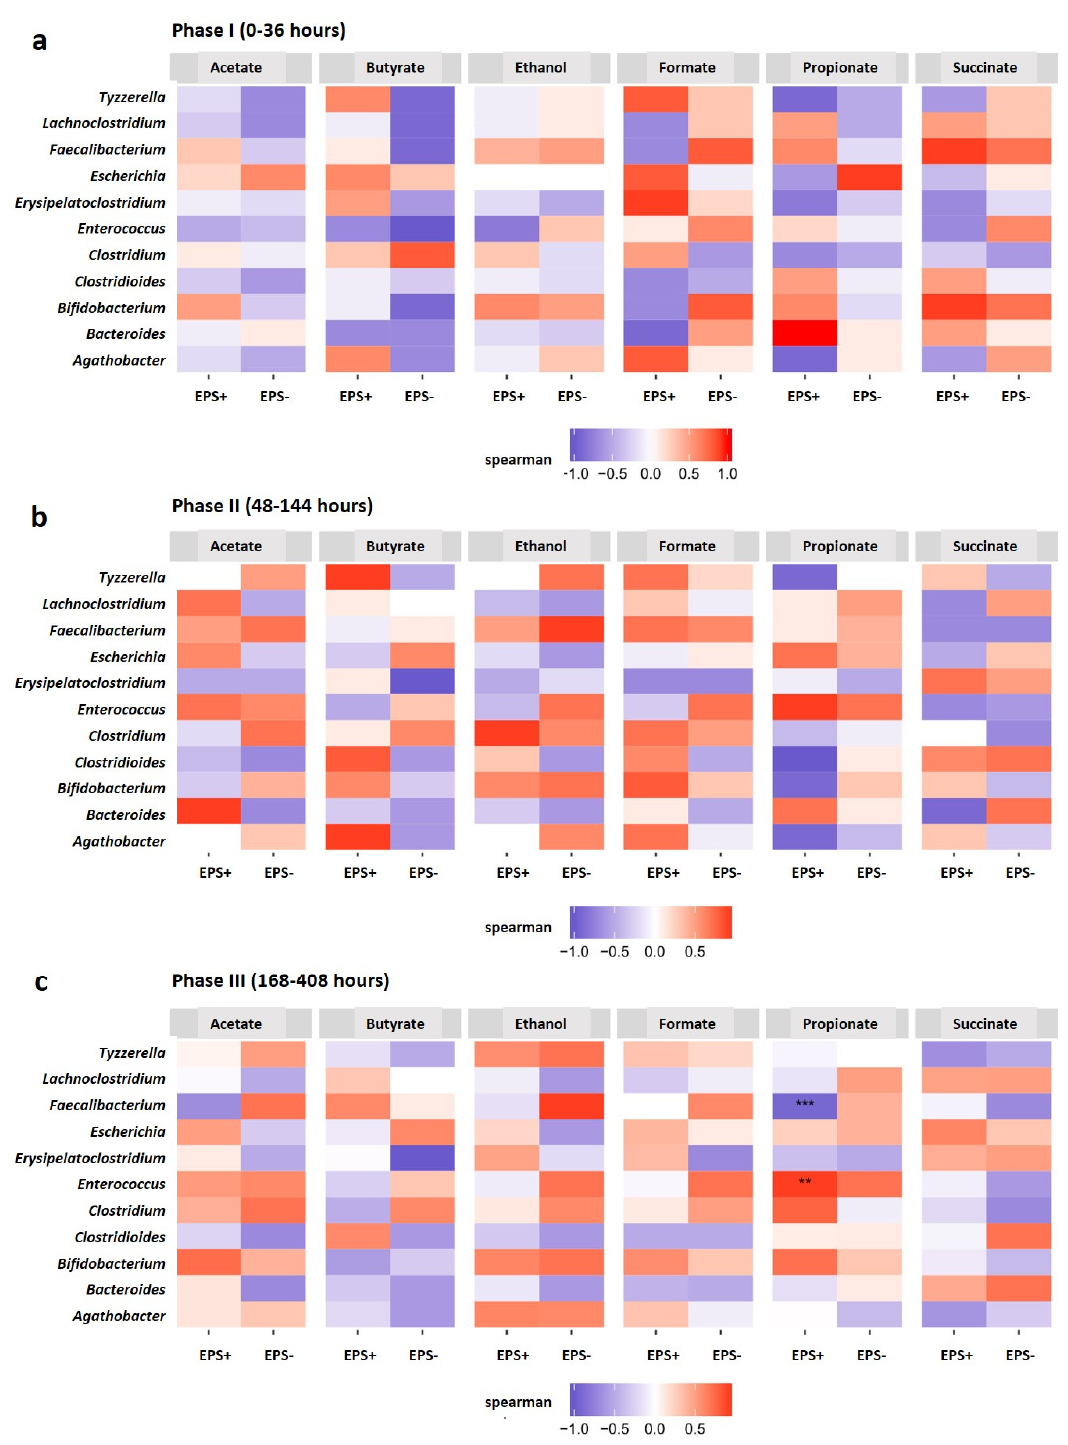
Figure 5. Spearman correlation between the top ten bacterial genera and top six abundant metabolites in each vessel (EPS+ vs. EPS − ) at each phase; ( a ); phase I, ( b ); phase II, ( c ); phase III. * p < 0.05; ** p < 0.01; *** p < 0.001. The p ‐ values are adjusted for multiple comparison using Benjamini & Hochberg by genus, and by each vessel (EPS+ and EPS −